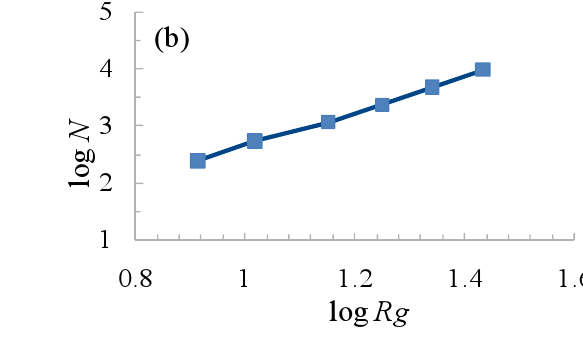
and generation of the dendrimer g